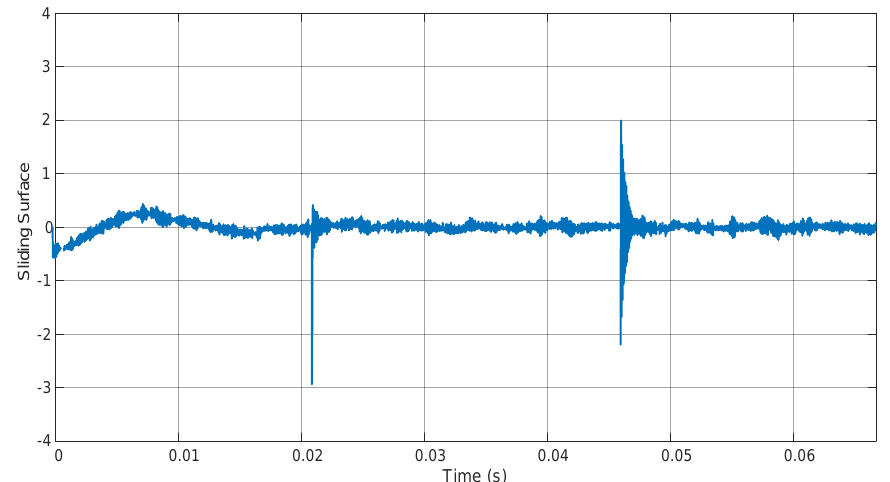
Figure 17. Tracking error between currents 𝑖 2 and 𝑖 2∗ with SMC plus P + R.